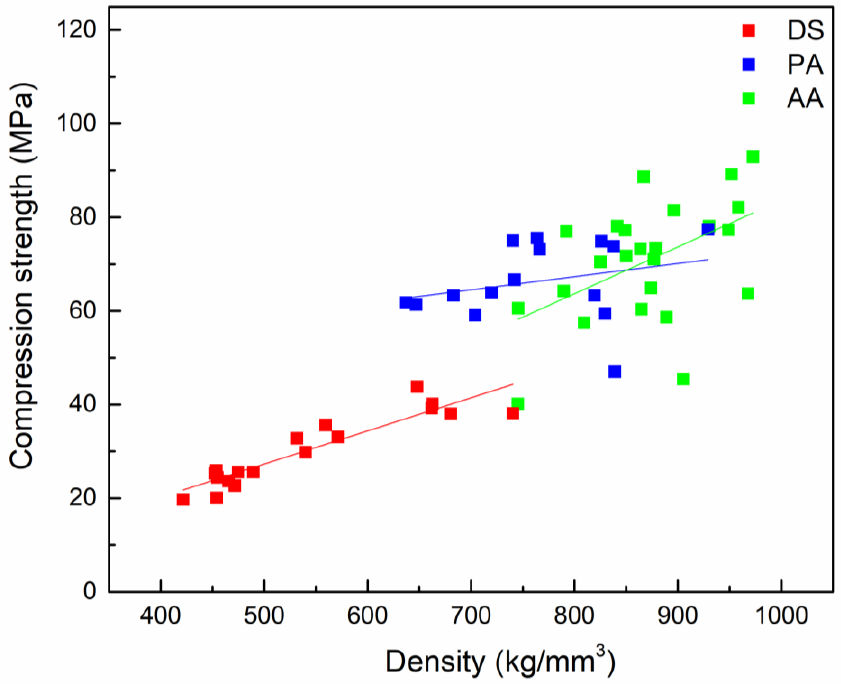
Figure 10. Graph showing relationship of compressive fracture stresses with density after 6 months ageing. The lines in the graph represent the linear regression of the values obtained for each species.